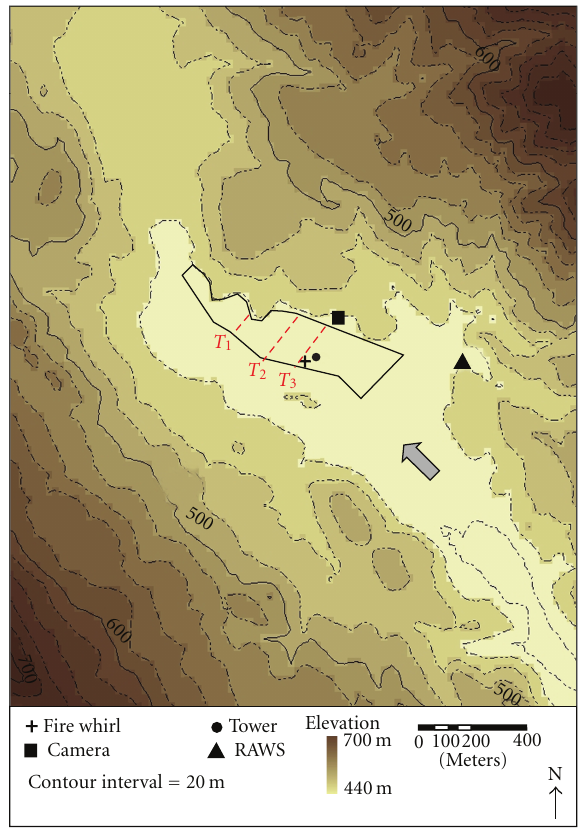
Figure 2: A map of the experiment site and instrument locations. The burn unit is indicated by the solid black line. The solid arrow indicates initial wind direction prior to the wind shift. The dashed red lines indicate approximate positions of the fire front: T 1 = 11 : 45, T 2 = 12 : 30, and T 3 = 12 : 42.